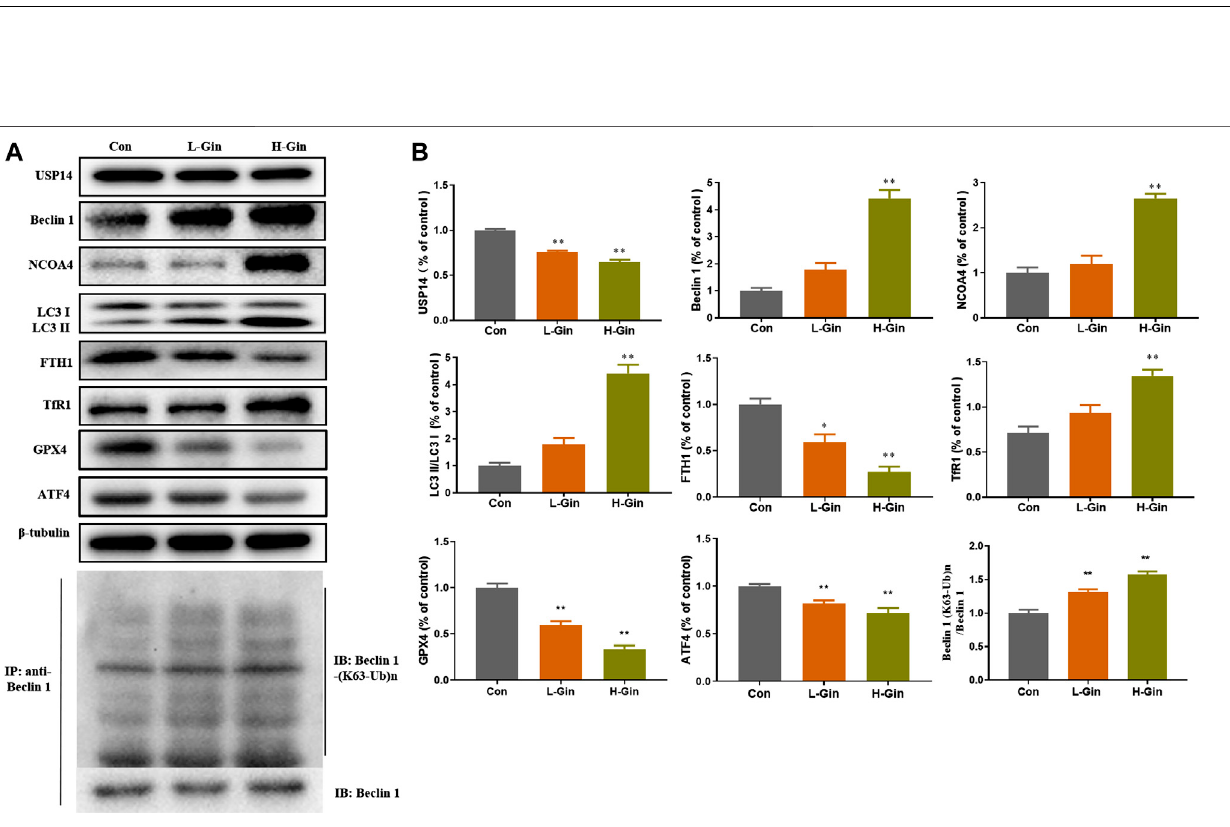
FIGURE5 | 6-Gingerolregulatesthe expression ofautophagy and ferroptosis related proteins in tumor. (A) The western blot analysis ofUSP14, Beclin 1, NCOA4, LC3 I, LC3 II, FTH1, TfR1, GPX4 and ATF4, Co-IP analysis of ubiquitination of K63 on Beclin one; (B) The densitometric analysis of the bands was presented as the relativeratioofUSP14,Beclin1,NCOA4,LC3II/LC3I,FTH1,TfR1,K63ubiquitinationonBeclinonetoBeclin1.Con:control,L-Gin:0.25 mg/kg/day6-Gingerol,H-Gin: 0.5 mg/kg/day 6-Gingerol. Compared with the control group, * p < 0.05, ** p < 0.01. Data are expressed as mean ± SD ( n (cid:2) 3).